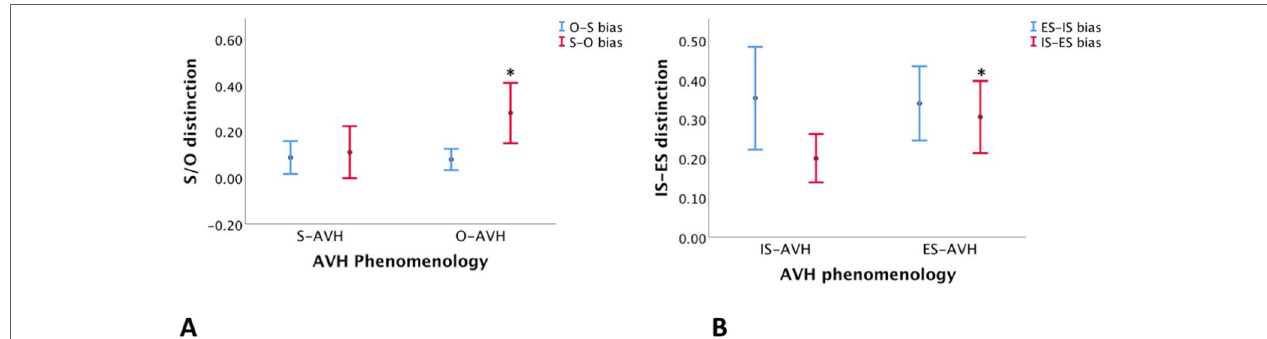
FIGURE 4 | (A) Differences in self–other (S–O)—red lines—and other–self (O–S)—blue lines—misattribution bias between subgroups of patients defined according to the agency experience of AVH: “voices” experienced as those of Self (S-AVH), and “voices” experienced as those of Other (O-AVH)). Only S–O bias difference was significant. (B) Differences in internal space–external space (IS–ES)—red lines—and external space–internal space (ES–IS)—blue lines—misattribution bias between subgroups of patients defined according to the spatial experience of AVH: “voices” experienced in internal space (IS-AVH), and “voices” experienced in external space (ES-AVH)). Only IS–ES bias was significant . *denote